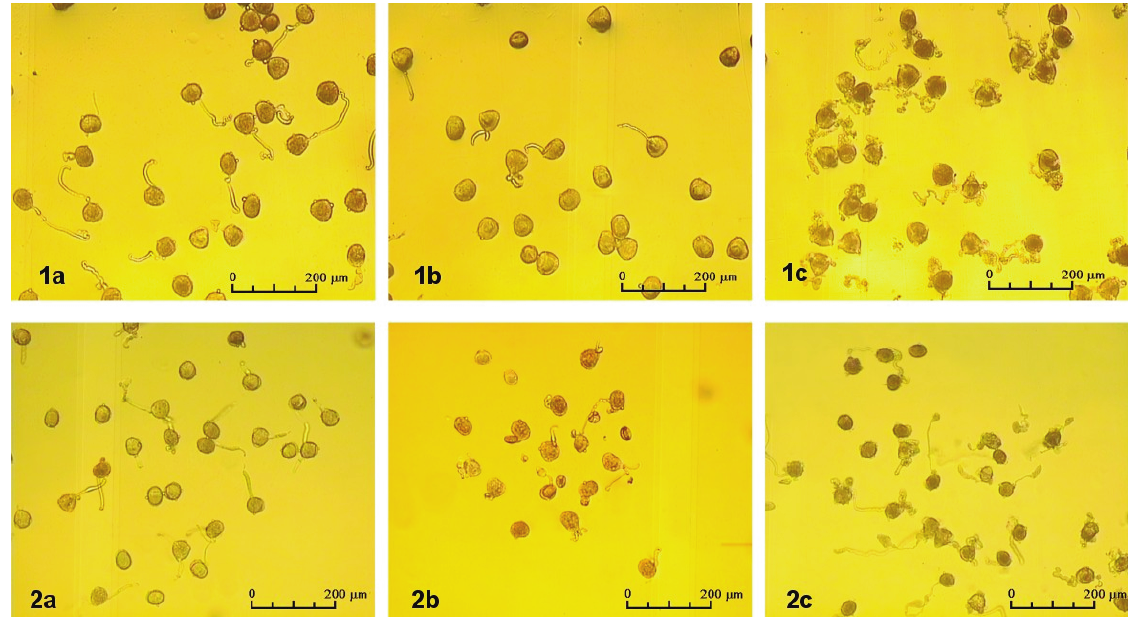
Fig. 2 ­ Pollen germination of L. grandiflorum (1) and L. hirsutum (2) on the media with PEG of different molecular weight and with sucrose: (a) PEG­2000, 30% + sucrose, 5% (b) PEG­6000, 30% + sucrose, 5%; (c) PEG­20000, 5% + sucrose,